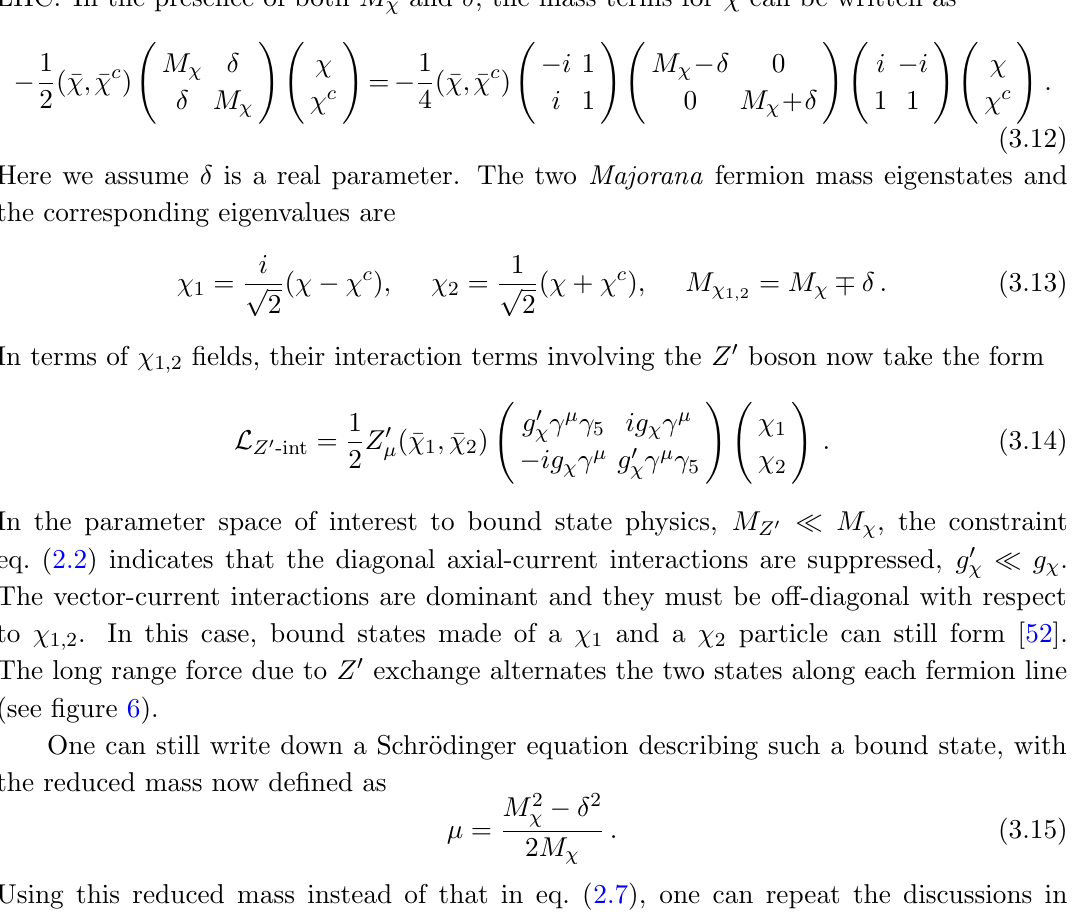
Figure 6 . Feynman diagram for a (cid:31) 1 - (cid:31) 2 bound